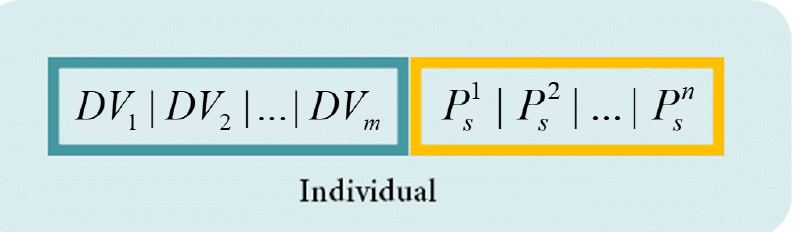
Figure 3. Individual chromosome